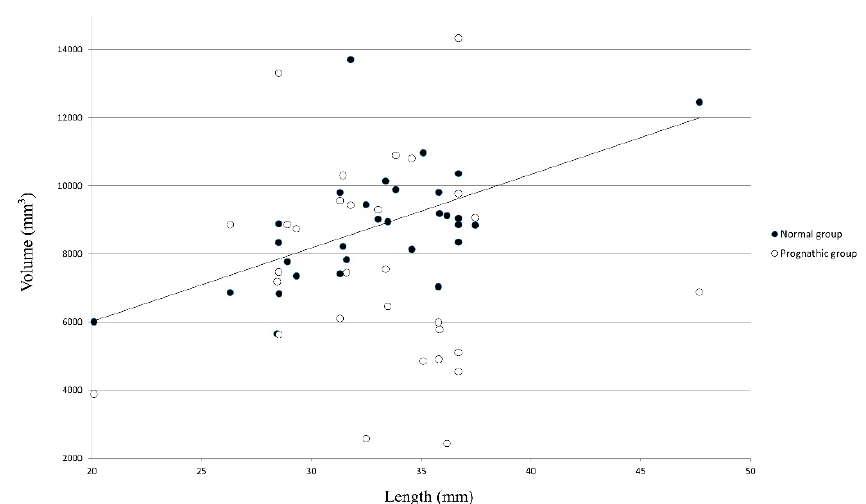
Figure 3. Distribution of lateral pterygoid volume/length ratios of prognathic and normal groups. Black and white points show normal and prognathic groups’ volume/length data, respectively. Blue dotted line represents trend line. Individuals of prognathic group are mainly located underneath trend line, while those in normal group are mainly located near and over trend line.